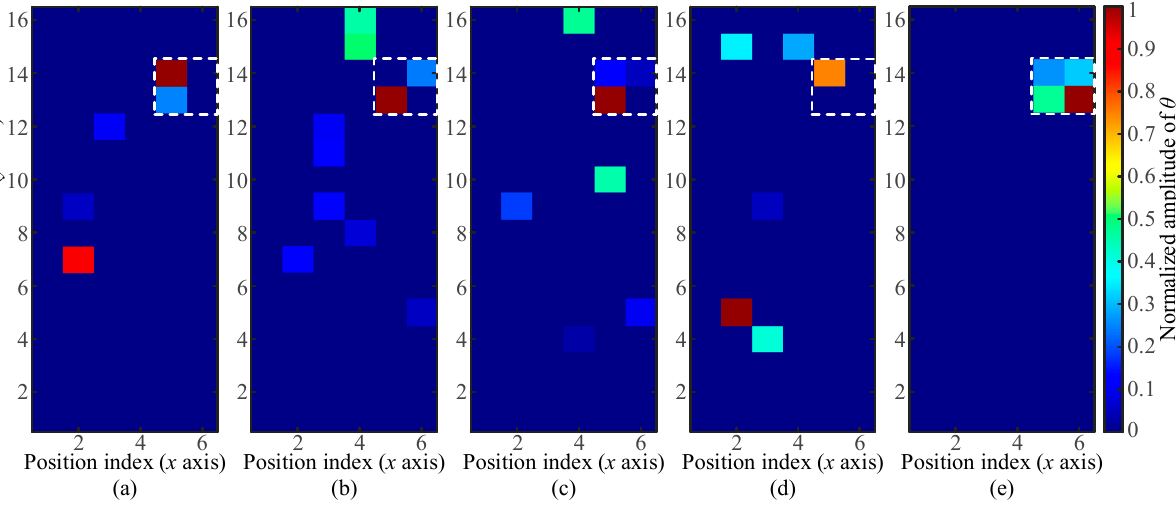
Figure 8. Localization results of a touch action of A t = 64 mm 2 and F t = 1.6 N with the database labelled as A t = 16 mm 2 . ( a – e ) Localization results, respectively, obtained with the reference databases of F t = 2 N, F t = 1.6 N, F t = 1.2 N, F t = 0.8 N, and F t = 0.4 N.